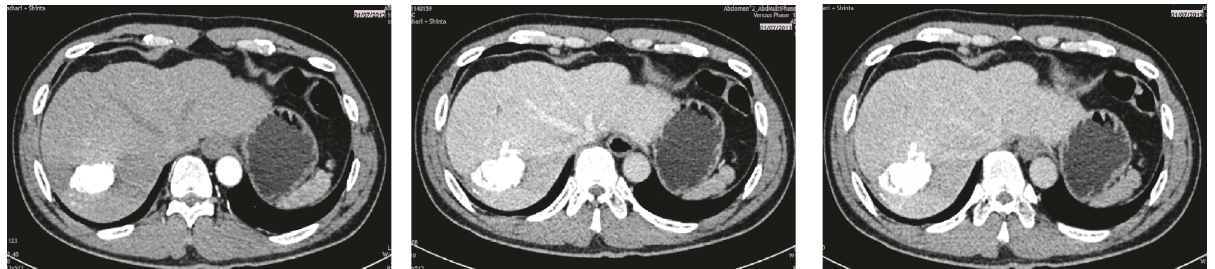
Figure 3: Arterial, venous, and delayed phase of Abdominal CT Scan after second DEB-TACE (May 2013).